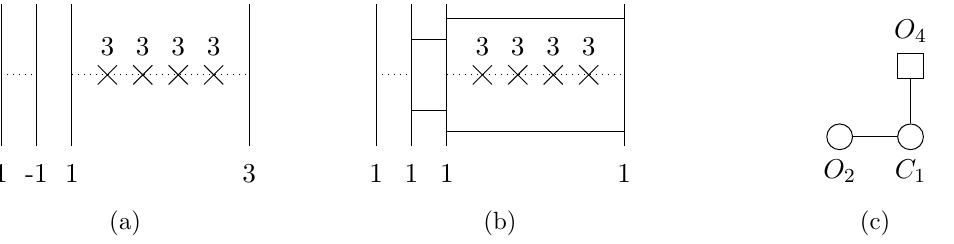
Figure 16. Orthosymplectic model with n s = n d = 4, ~l d = (3 ; 3 ; 3 ; 3), ~l s = (1 ; 1 ; 1 ; 1) and rightmost orientifold plane of type O 3 (cid:0) . (a) is the (cid:12)rst step to achieving the right brane con(cid:12)guration, the linking numbers of the half D5-branes are correct, but the half NS5-branes have ~l s = (1 ; (cid:0) 1 ; 1 ; 3). Linking numbers of half NS5-branes are displayed below them, linking numbers of half D5-branes are displayed above them. In this case the rightmost O3-plane, the leftmost one and the one between the second and third half NS5-branes are O 3 (cid:0) . The dotted lines represent either O 3 + or g O 3 + . In this con(cid:12)guration the O 3 (cid:0) turns into O 3 + after crossing through half an NS5-brane. The g O 3 + s are found after an O 3 + crosses half a D5-brane. In (b) two physical D3-branes have been added and the linking numbers are the desired ones. The quiver can be read from (b), and is depicted in (c). The group C 0 has been